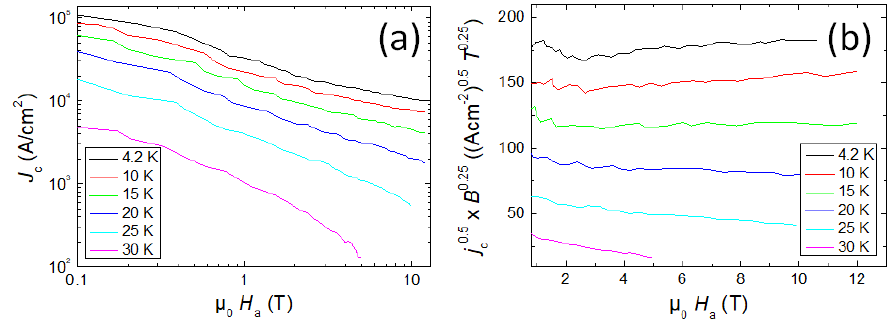
Figure 3. (a) double logarithmic plot of j c as function of the applied field, µ 0 H a . (b) Corresponding Figure 3. ( a ) double logarithmic plot of j c as a function of the applied field, µ 0 H a ; ( b ) Corresponding Kramer plot of the same data set. Kramer plot of the same data